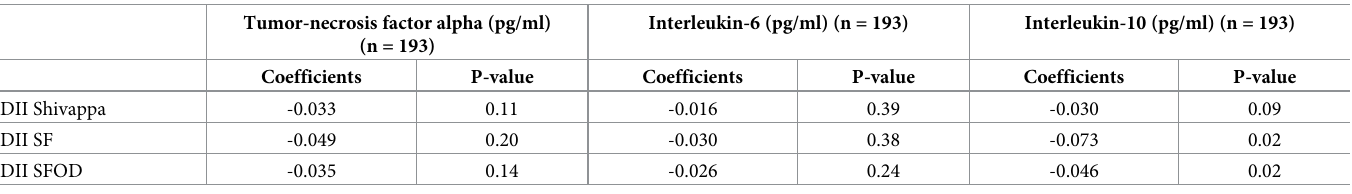
� Data are presented as unstandardized regression coefficients of linear regression analyses adjusted for age and sex in n = 193 subjects of the TEENDIAB study. Cytokine levels were